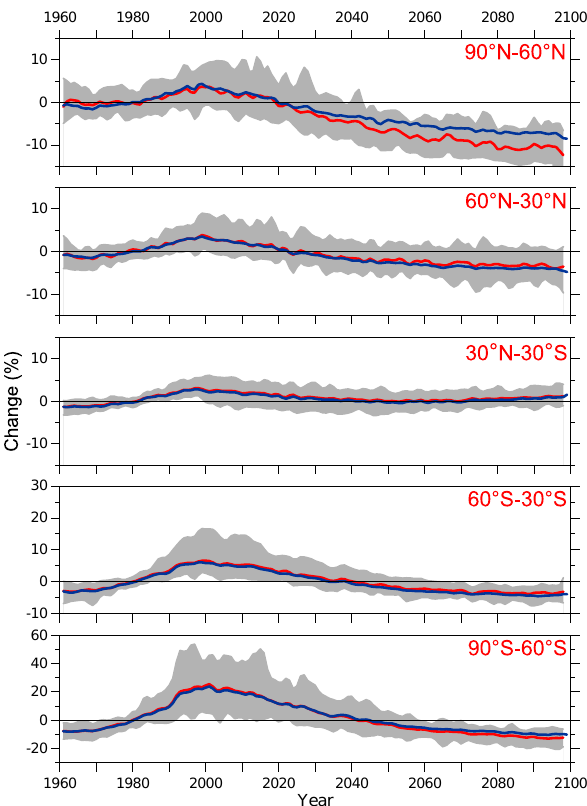
Fig. 2. Annual means of surface erythemal irradiance changes (in %, relative to the 1975–1985 mean) for five latitude bands as indi- cated in each panel. UV-Ery was calculated with a radiative transfer model using projections of ozone and temperature from 14 CCMs and of clouds from 5 CCMs. The red thick line represents the multi model mean and the shaded envelope shows the range of model variations. The blue line represents the multi model mean for cloud free conditions. All lines have been smoothed with a 1:2:1 filter. Note the different scale for the two Southern Hemisphere bands.